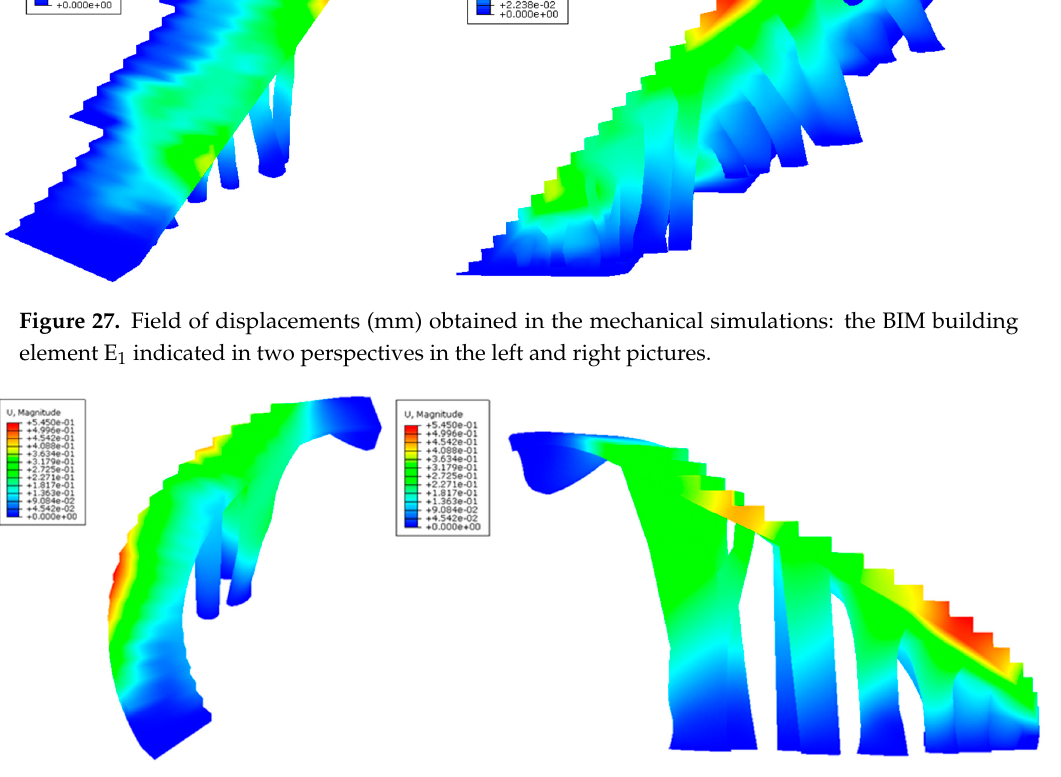
Figure 28. Field of displacements (mm) obtained in the mechanical simulations: the BIM building element E 2 indicated in two perspectives in the left and right pictures. Table 9. Results of the numerical mechanical analyses of the BIM, E 1 and E 2 construction elements.